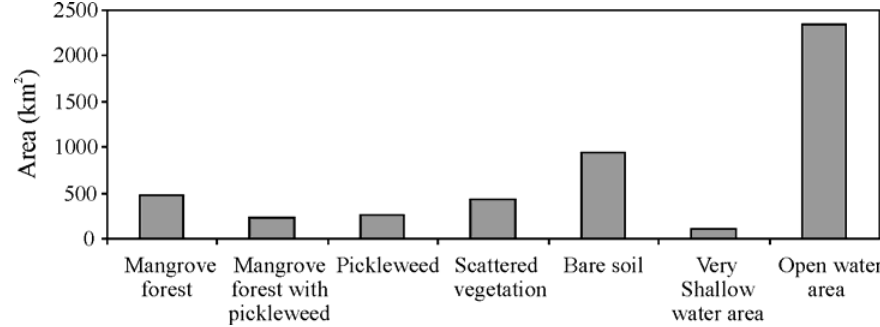
Figure 5. Estimated coverage (km 2 ) of each category in the study